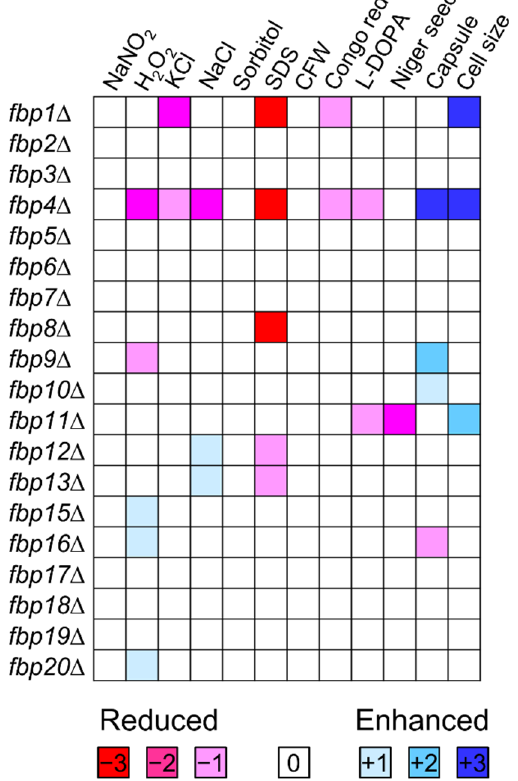
Figure 1. Phenotypic clustering of F-box proteins in C. neoformans . Phenotypic assays were examined under different conditions and scored on a 7-point scale. − , reduced. +, enhanced.